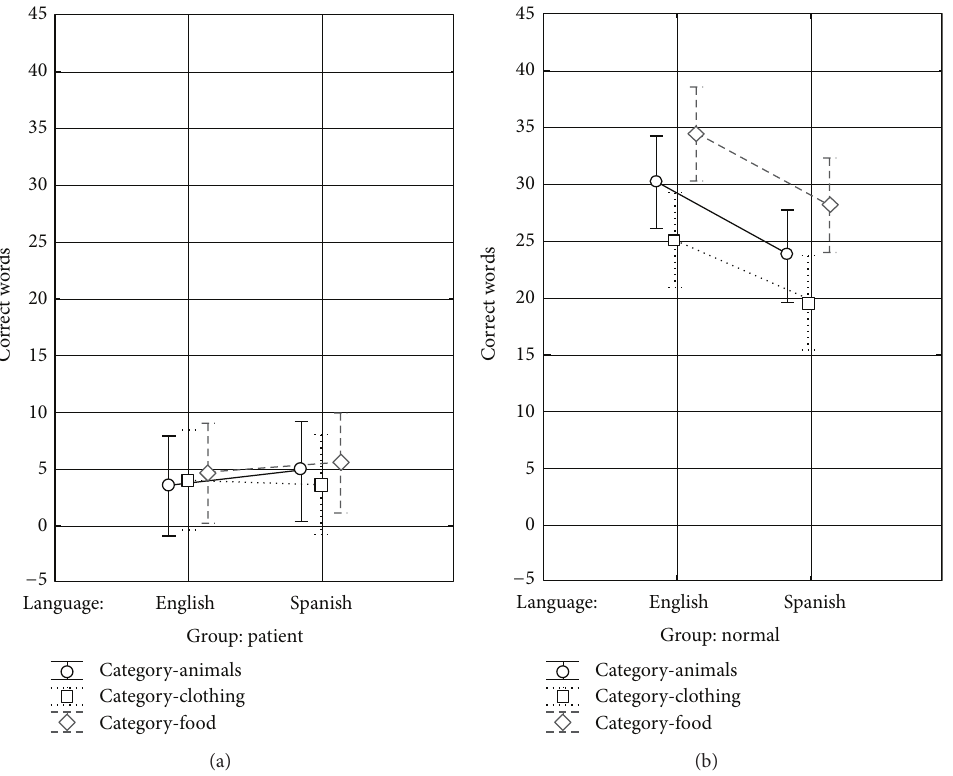
Figure 3: Mean number of correct words for the category generation task for (a) patients with aphasia and (b) normal controls in English and Spanish for three categories: animals, clothing, and